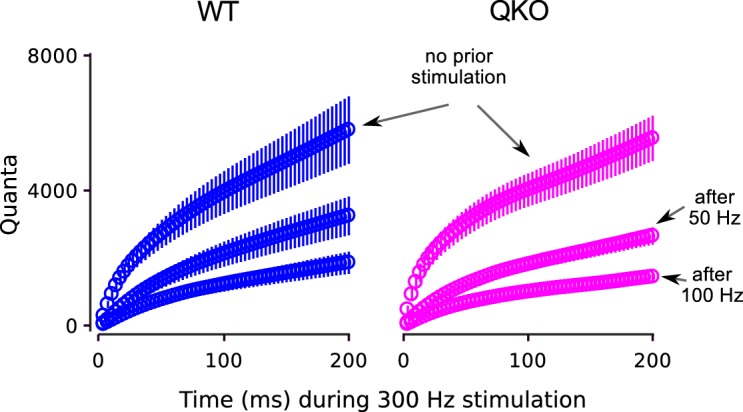
Cumulative plots for full experiment.Cumulative plots of release during frequency jump experiments. Cumulative release during 300 Hz stimulation without and with prior submaximal stimulation at 50 or 100 Hz; same experiments as documented in Figure 5. The lesser release after 100 Hz compared to after 50 Hz indicates that 100 Hz stimulation depleted the RRP to a greater extent than 50 Hz stimulation. This is expected - even if 50 Hz stimulation is sufficient to completely eliminate vesicles with high pv - because the vesicles with low pv are released at a low rate during submaximal stimulation, causing partial depletion of the low pv subdivision of the RRP in addition to the full depletion of the high pv subdivision; see Mahfooz et al. (2016).